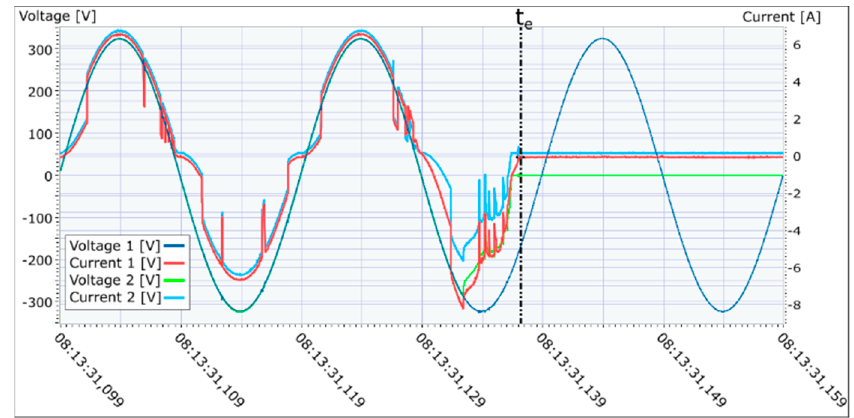
Figure 8. Instant ( t e ) at which the circuit was opened by the AFDD (using the Bourns 2049-09 surge arrester).